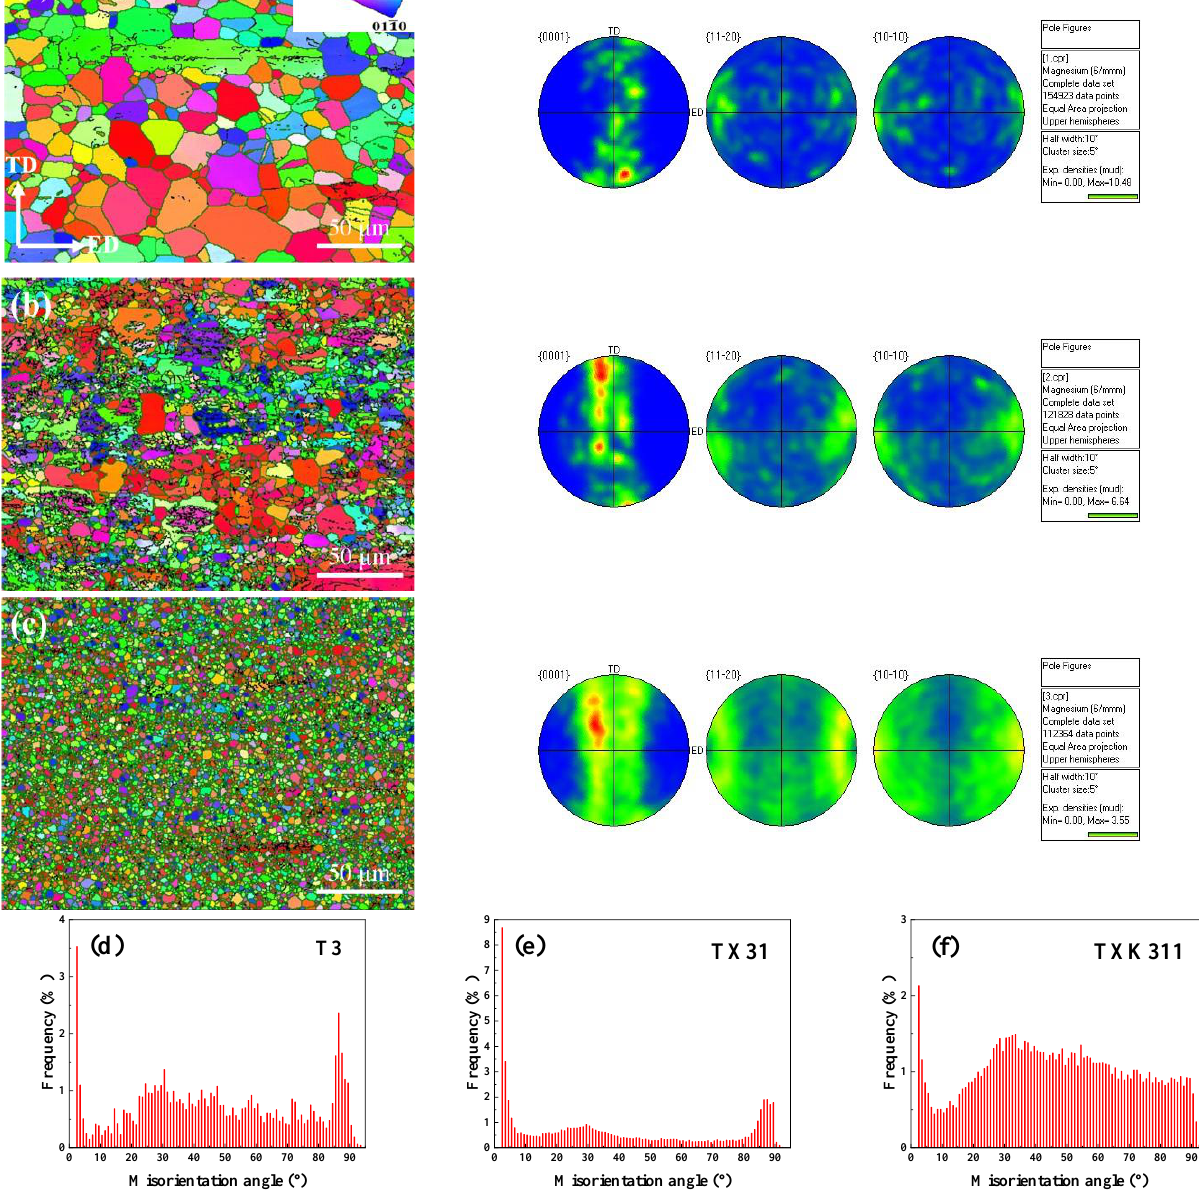
Figure 5. IPF and PF maps of as-extruded alloys: ( a ) T3, ( b ) TX31, ( c ) TXK311; ( d – f ) Misorientation angle distribution of three as-extruded alloys. Figure 6 shows the EBSD diagram of different types of grain distribution of the as- extruded T3, TX31, and TXK311 alloys and the corresponding fractions of each region. Blue, yellow, and red areas represent recrystallized grains, sub-grains, and deformed grains, respectively. Studies have shown that when the extrusion temperature of Mg alloy exceeds 350 °C, there is a completely dynamic recrystallization [34 – 37]. Due to the extru- sion temperature set in this work being 300 °C, the completely dynamic recrystallization occurred in the three alloys during extrusion. It can be seen from the figure that the re- crystallized grain fraction of the T3 alloy was 66%, and the sub-grain fraction was 32%, with a small quantity of deformed grains. After adding 1% Ca alone, the microstructure of the alloy was composed of a small amount of dynamic recrystallized grains and se- verely elongated non-dynamic recrystallized grains. The proportion of dynamically re- crystallized grains was only 18%, while the deformed grains increase to 50%. After adding